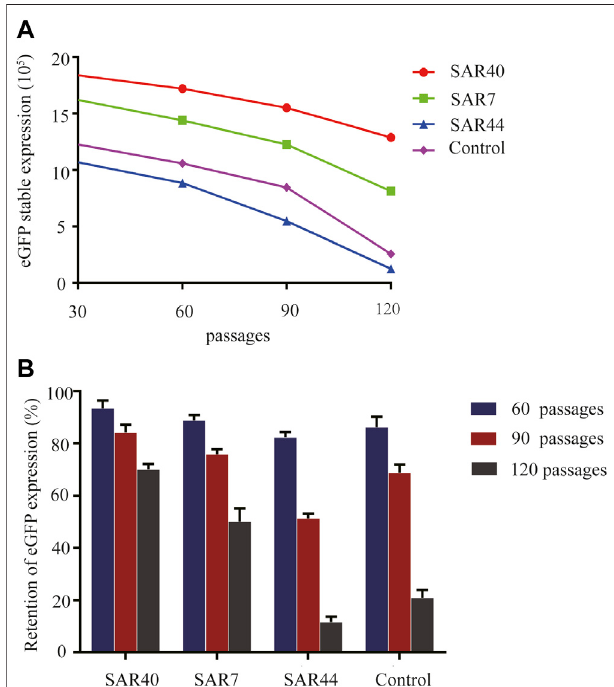
FIGURE 5| Analysis of long-term stabilityof the transgene expression in transfected CHO cells. Cells were collected, and FACSCalibur estimated the eGFP fl uorescence pro fi le at generation 30, 60,90, and 120 after transfection. (A) The eGFP expression (MFI) on different days after transfection. (B) The retention of eGFP expression of different constructs. The results are the mean values obtained for three independent experiments, and the standard deviation is